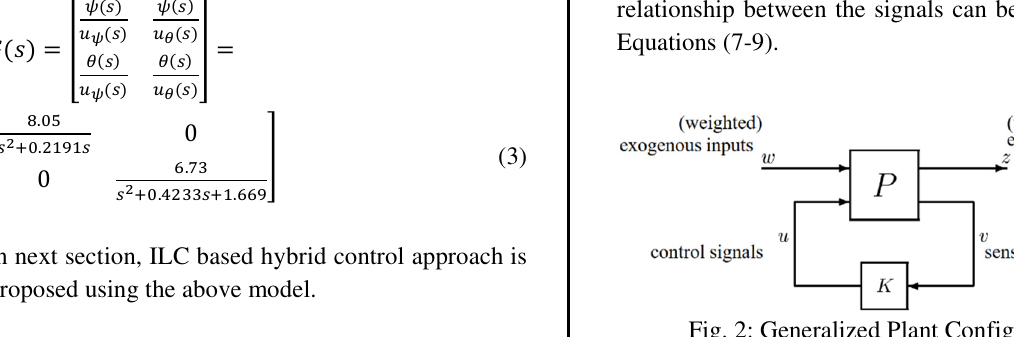
Fig. 2: Generalized Plant